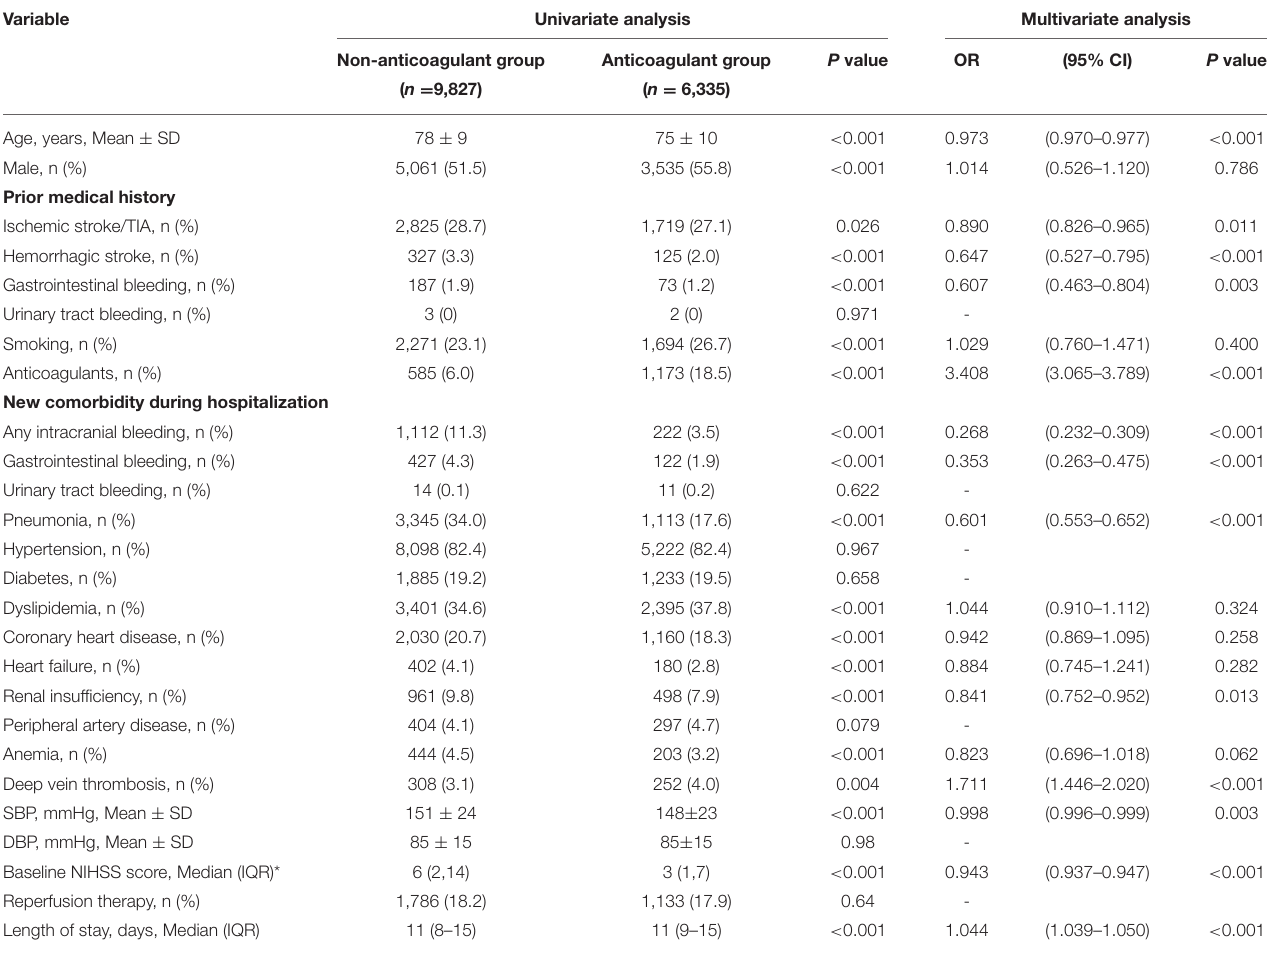
TABLE 2 | Univariate and multivariate analysis for the initiation of anticoagulation at discharge. Variable Univariate analysis Multivariate analysis Non-anticoagulant group Anticoagulant